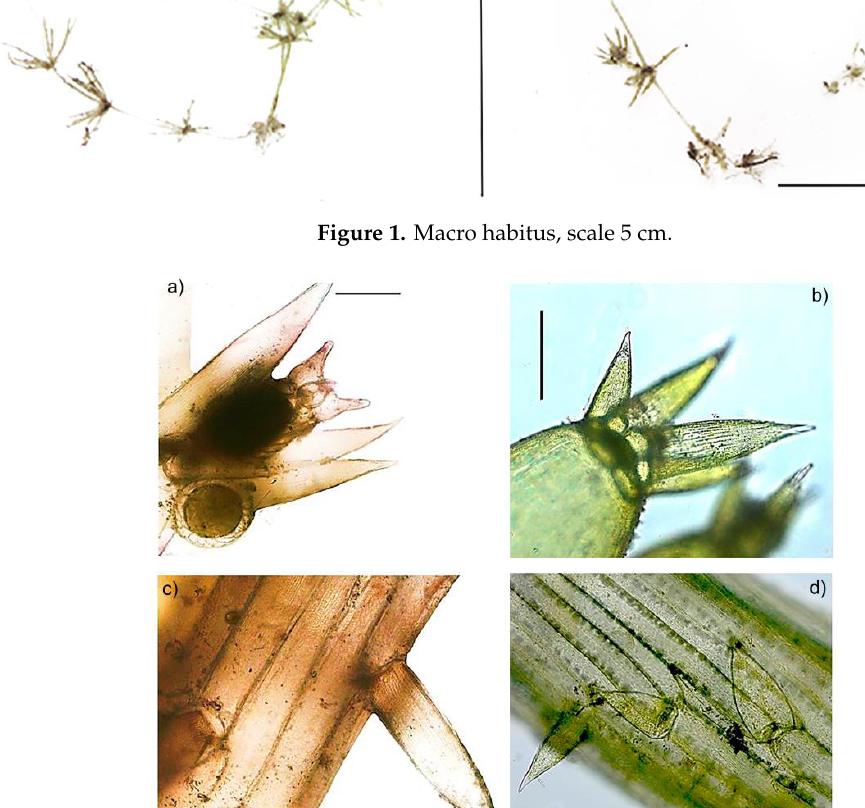
Figure 2. Microscopic taxonomic features: ( a ) Gametangia, ( b ) terminal corona on the branchlet terminal segment, ( c ) triplostichous, isostichous cortex, ( d ) cortex detail showing irregular structure, scale 200 µm.